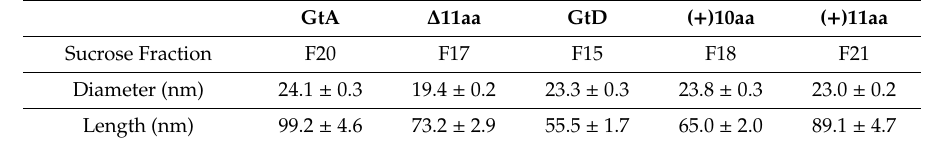
Table 2. Summary of the filament-representing fractions and filament size.